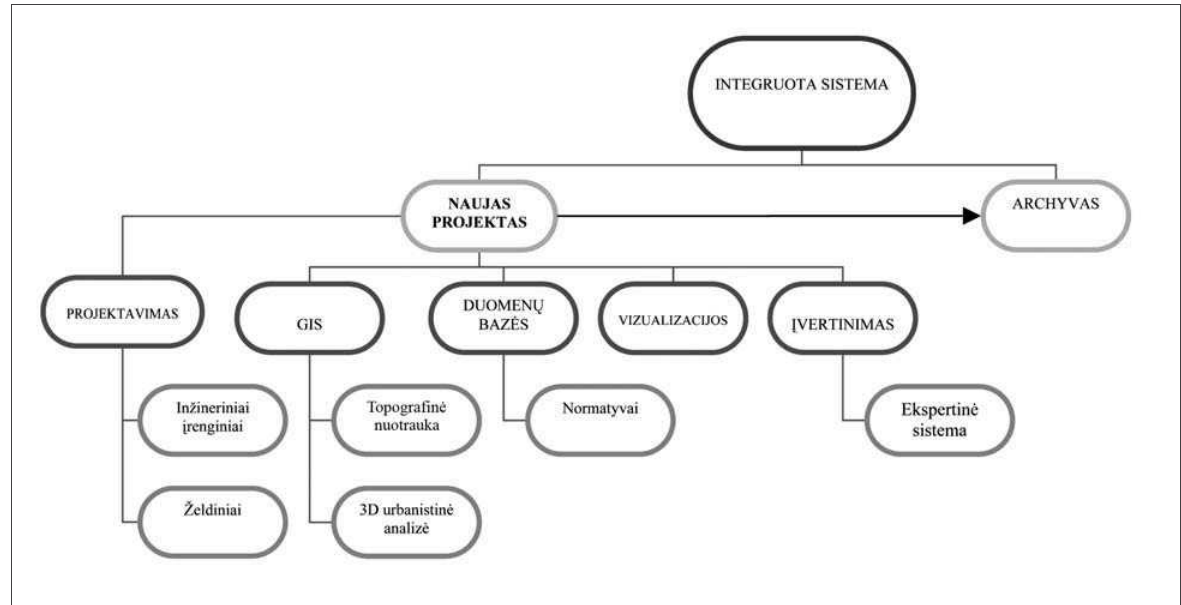
5 pav. Integruotos sistemos fragmentas Fig 5. Fragment of integrated